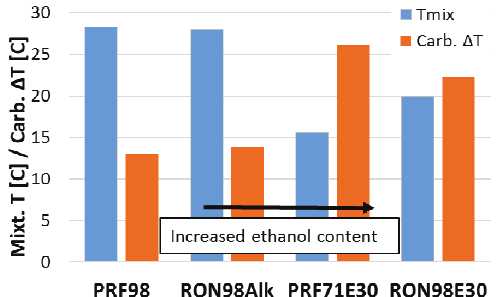
Fig. 3. Mixture temperature after the carburetor and corresponding tem- perature drop across the carburetor Focusing on the engine operating conditions of peak knock for each fuel, the gross indicated mean effective pressure (IMEPg) is shown in Fig. 4 . As shown in Fig. 5 , the less-rich peak knocking lambdas of the E30 fuels al- lowed for more efficient engine operation and higher en- gine load during RON test conditions. The increased fuel rates with the E30 fuels does not seem to be the cause of increased load, being that the total fuel energy rate being supplied to the engine actually decreased when considering the reduction in fuel lower heating value (LHV) observed in Table 5. It is not clear whether this increase in engine load might have an effect on the knockmeter measurements, and in the end of the RON rating of these